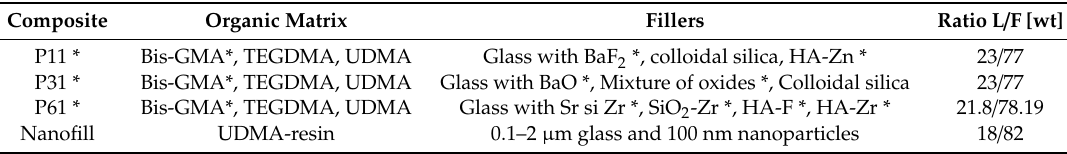
Table 1. Composition of investigated composite